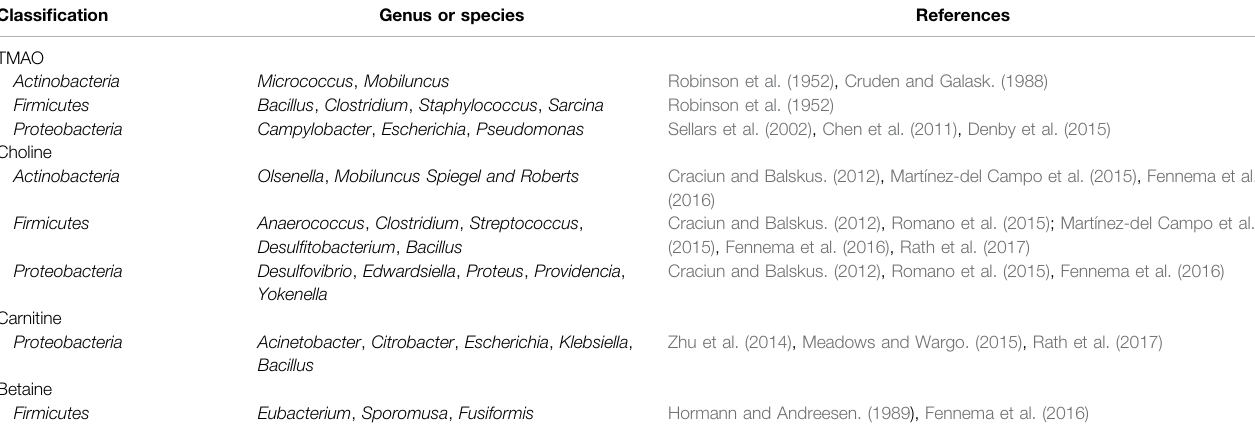
TABLE 2 | The microorganisms affecting the metabolism of TMAO, carnitine, choline and